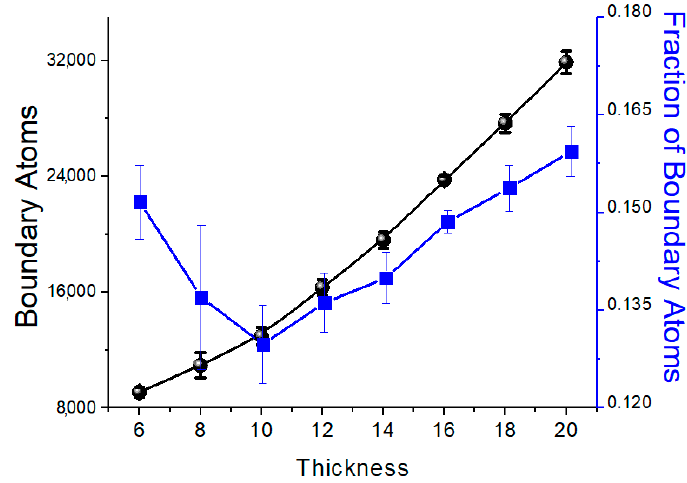
Figure 2. Number of boundary atoms and the fraction of them with respect to the sample for different thicknesses. The average grain volume was kept constant at 𝐿 2 atoms.